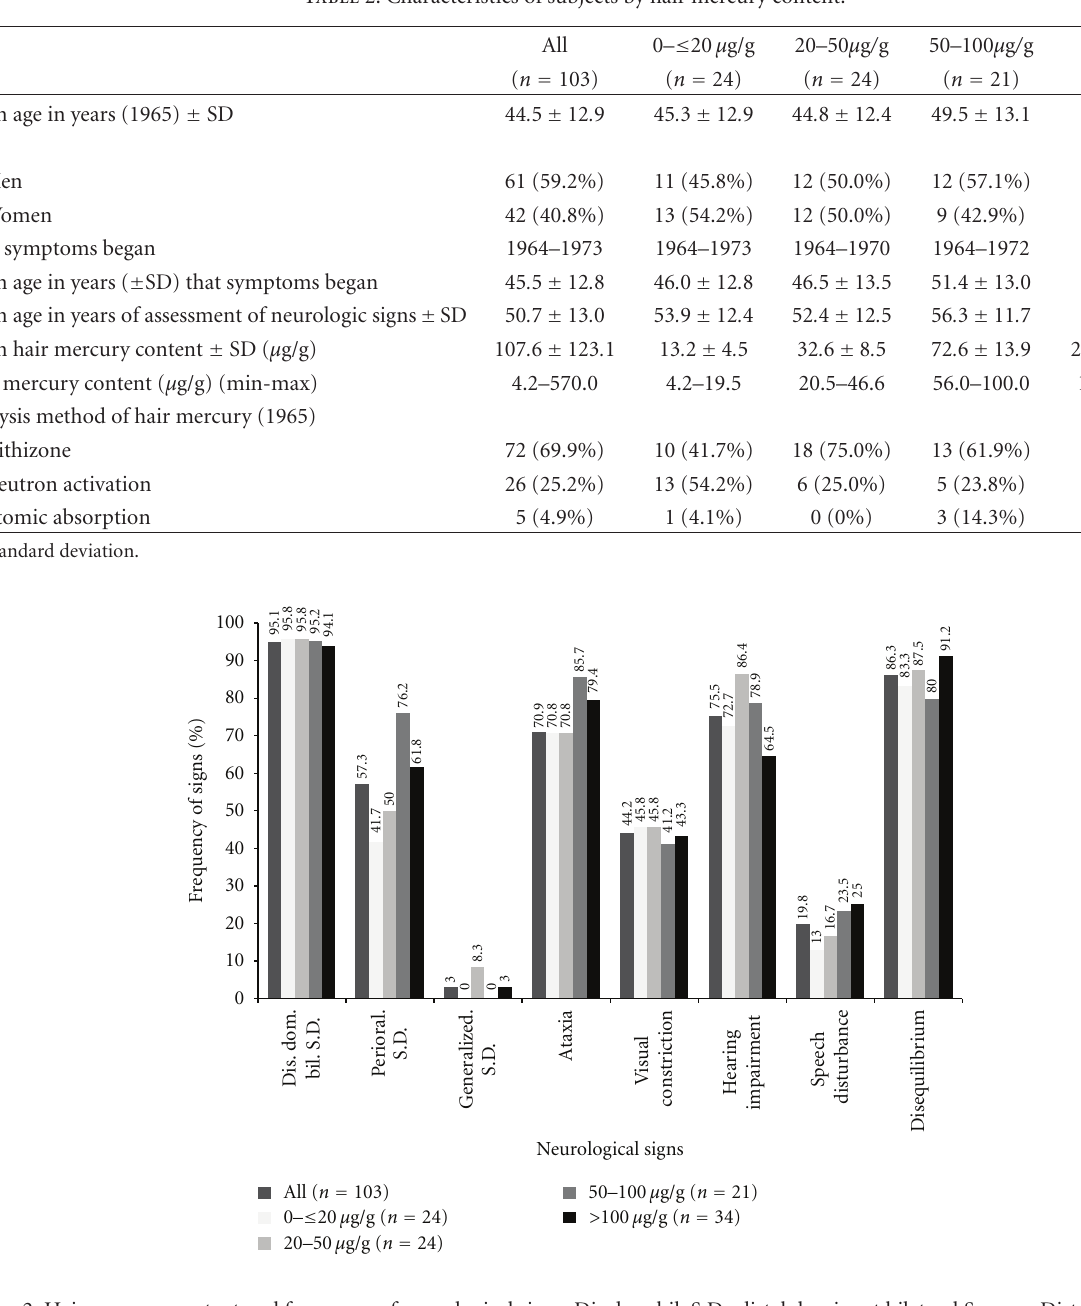
Figure 2: Hair mercury content and frequency of neurological signs. Dis.dom.bil. S.D.: distal dominant bilateral Sensory Disturbance S.D.: sensory